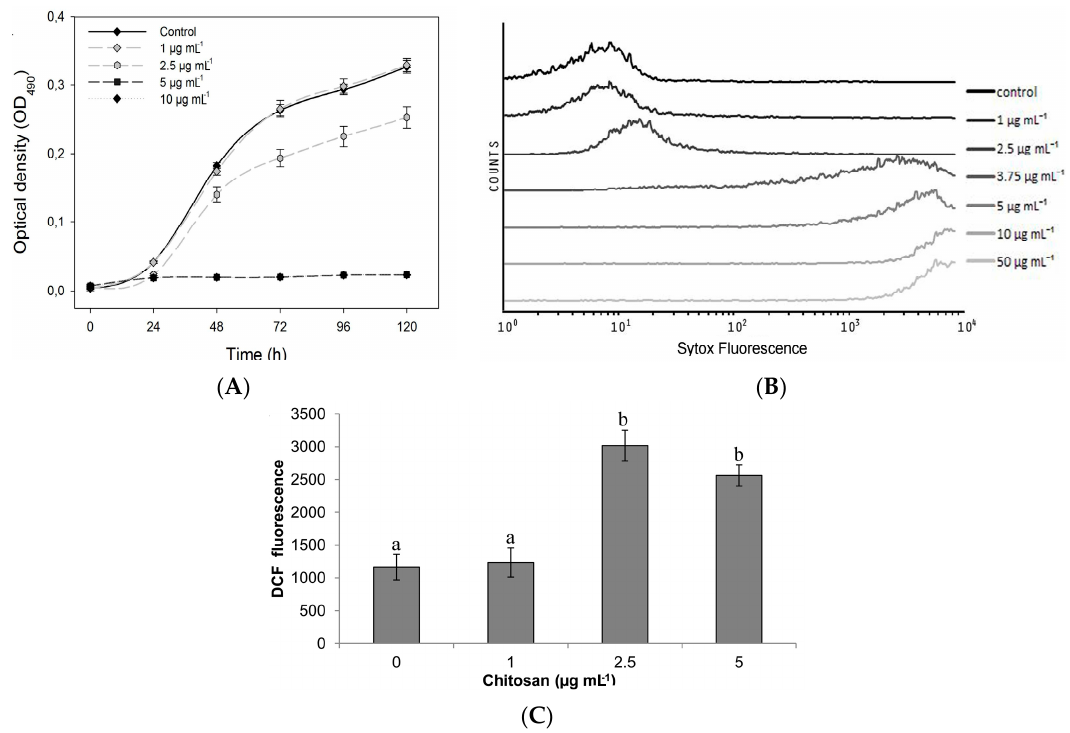
Figure 2. Chitosan inhibits growth of filamentous fungi (e.g., N. crassa ) at low doses ( A ) by means of plasma membrane permeabilization which can be detected by flow cytometry ( B ); This process is preceded by early induction of intracellular oxidative stress detected by 2’–7’ dichlorofluorescein diacetate (DCF). Letters indicate statistical differences ( p < 0.05) between chitosan concentrations ( C ); Graphs obtained from Lopez ‐ Moya et al. 2015.